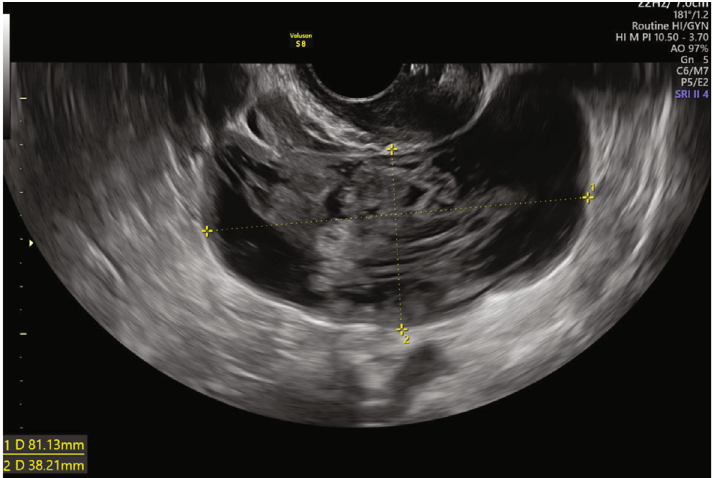
Figure 1: The transvaginal sonography revealed a right adnexal complex mass measuring 8 : 1 × 3 : 8cm that did not resolve after three months of expectant management.